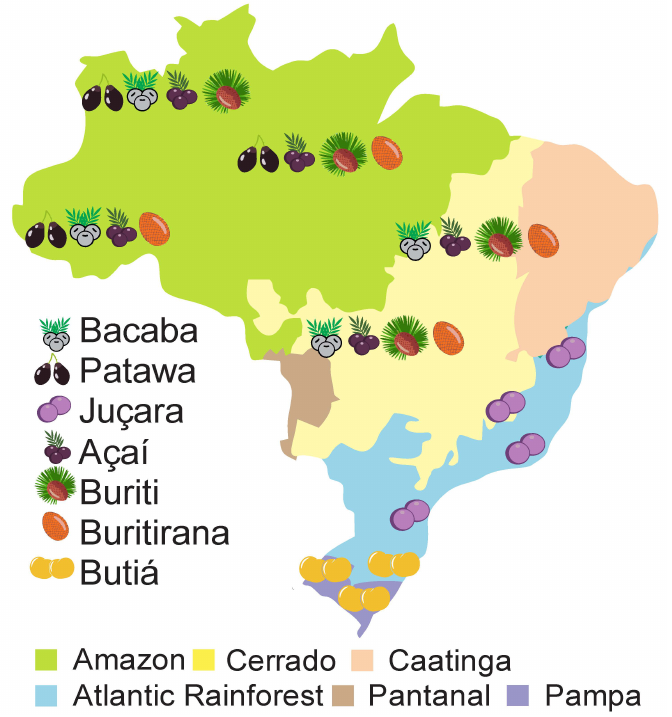
Figure 1. Distribution of seven native Brazilian fruits belonging to the Arecaceae family, across six biomes: Amazon, Cerrado, Atlantic Rainforest, Caatinga, Pantanal, and